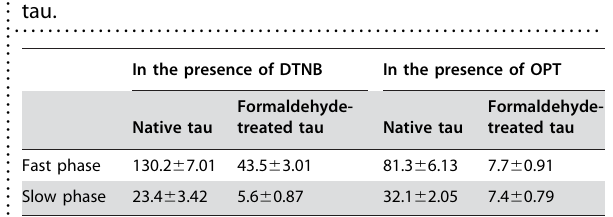
Table 1. The first order rate constants of DTNB and OPT reacting with native tau and 0.005%